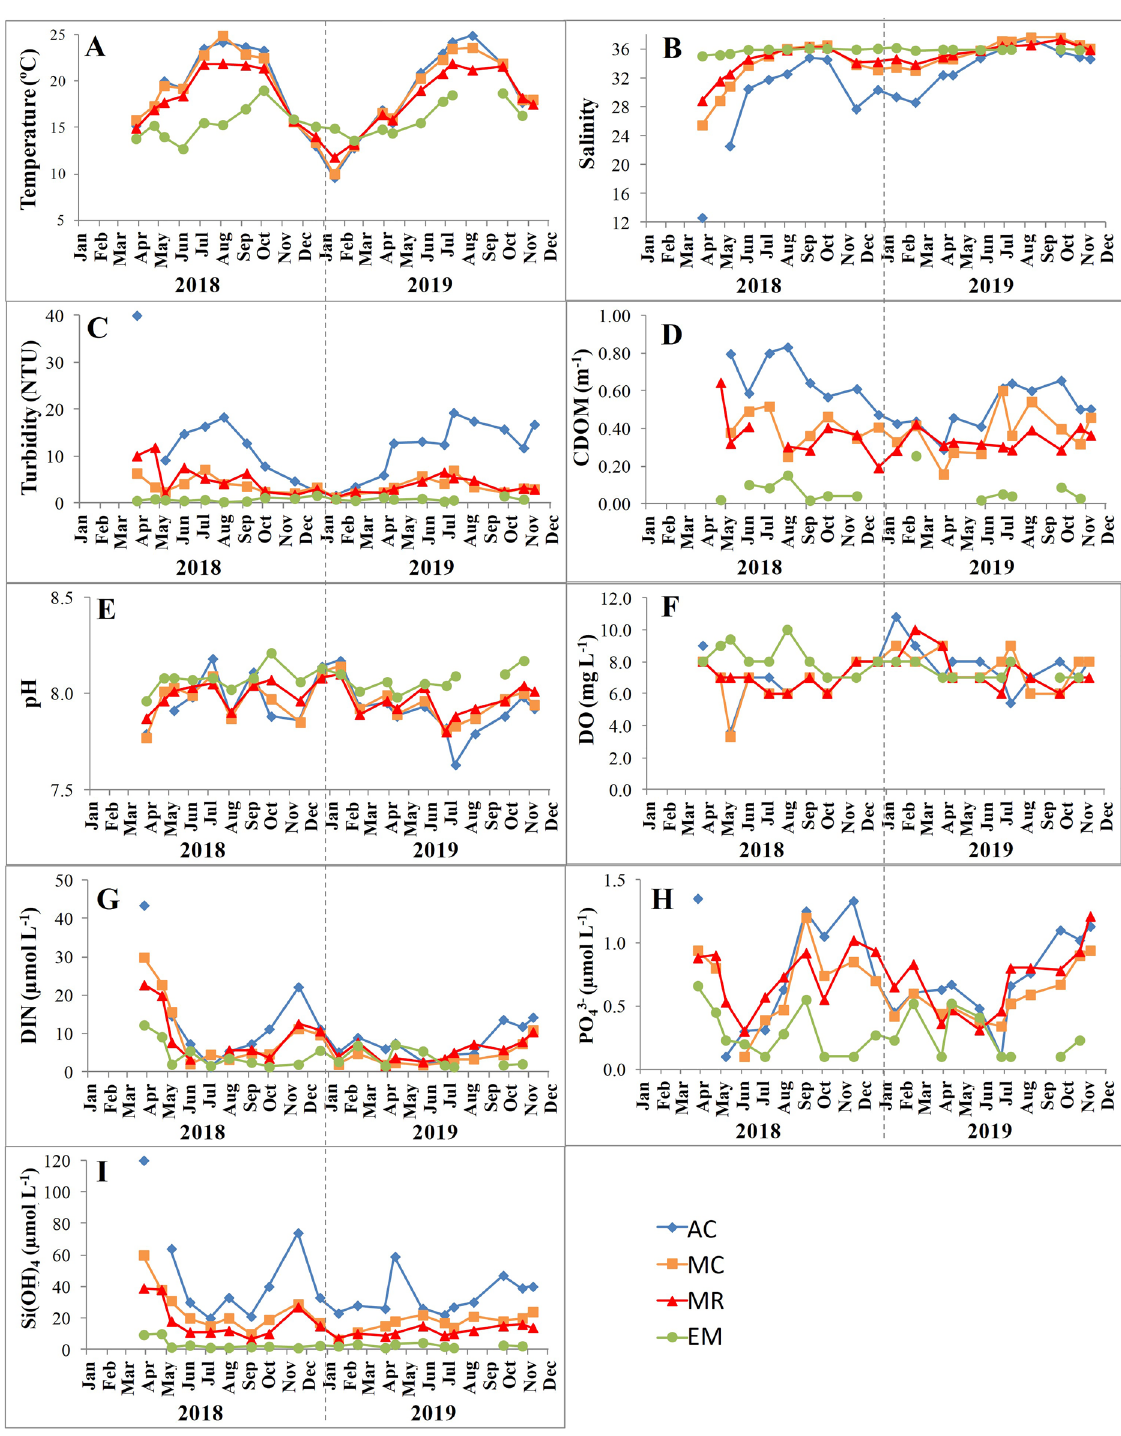
Figure 2. Discrete time series of physico-chemical variables obtained in the Sado Estuary during sampling surveys. ( A )—Water temperature (°C); ( B )—Salinity; ( C )—Turbidity (NTU); ( D )—Coloured dissolved organic matter at 443 nm (CDOM, m −1 ); ( E )—pH; ( F )—Dissolved oxygen (DO, mg L −1 ); ( G )—Dissolved inorganic nitrogen (DIN, µmol L −1 ); ( H )—Phosphate (PO 43− , µmol L −1 ); and ( I ) –Silicate (Si(OH) 4 , µmol L −1